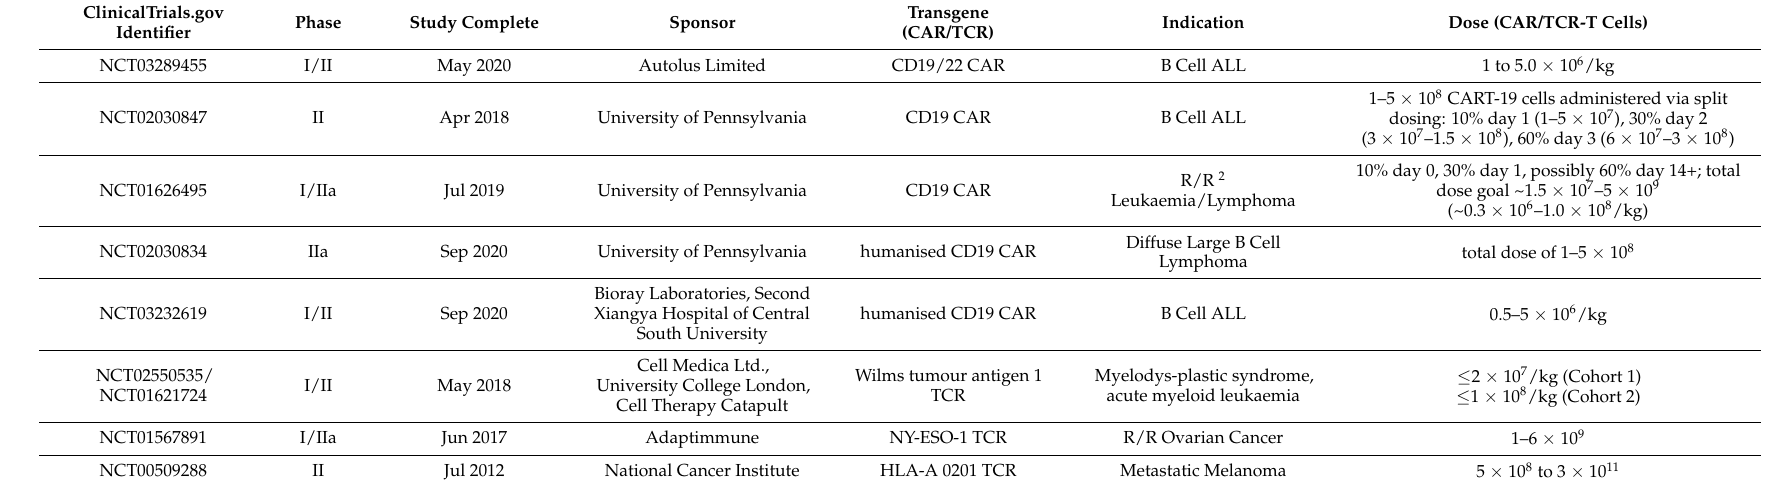
Table 2. CAR and TCR-T cell doses for blood and solid tumour indications, respectively 1